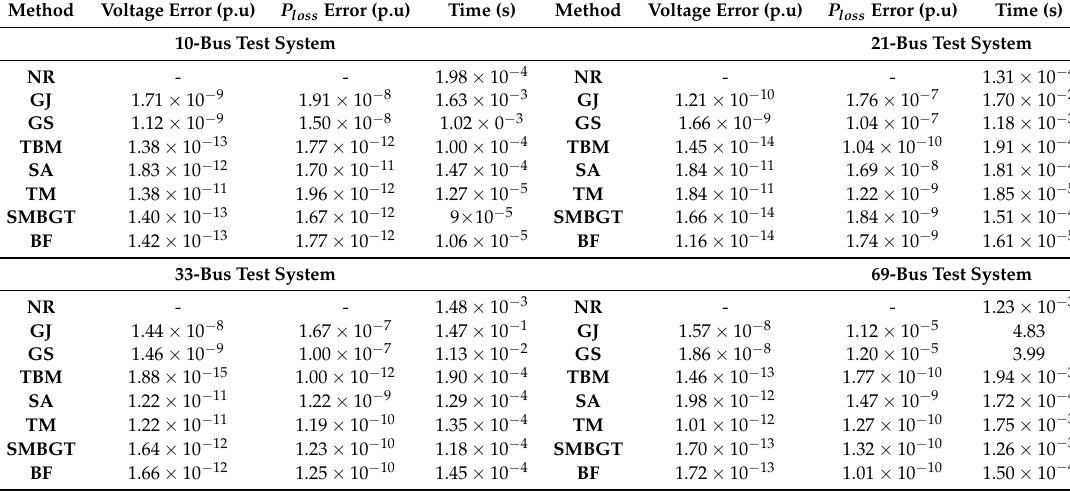
Table 4. Results obtained for test systems with radial structure.